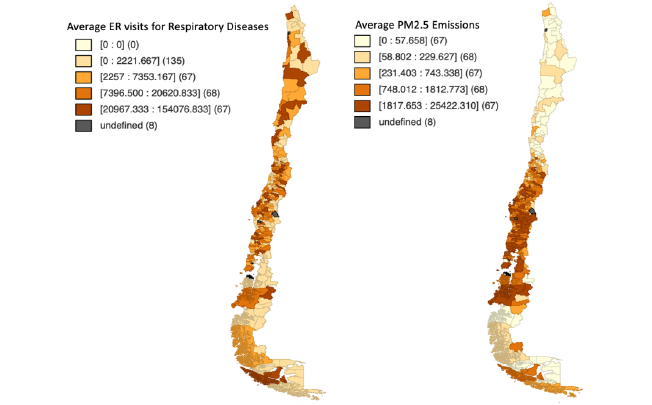
Figure 2: Spatial distribution of ER visits and PM2.5 emissions at municipality level. 10- and 7-closest neighbors for each municipality. We do not consider the simple binary geographic unit matrix since it is hard to argue that air pollution only affects first order neighbors. For a similar reasoning see Chen et al.